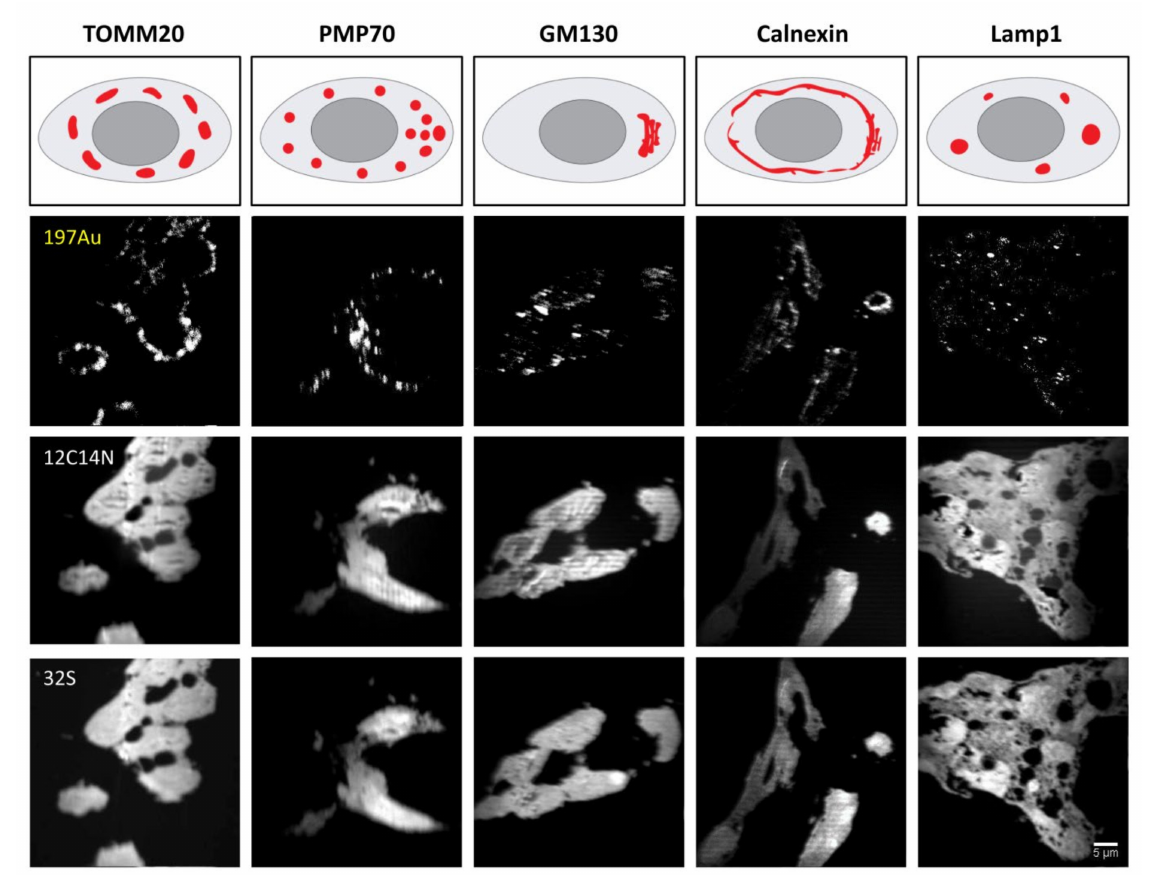
Figure 2. NanoSIMS detection of 6 nm Au_Np-tagged HEK293 organelle markers. Schematic representation of the expected organelle distribution from thin tissue slices after embedding and sectioning. The 197Au signal from antibody labeling represents the specific targeted protein, while the 12C14N and 32S signals reveal the cells. The signals are produced by a broad range of biological materials (proteins, DNAs, RNAs, etc.) that contain a substantial amount of C, N and S elements. One representative nanoSIMS image from each organelle labeling is